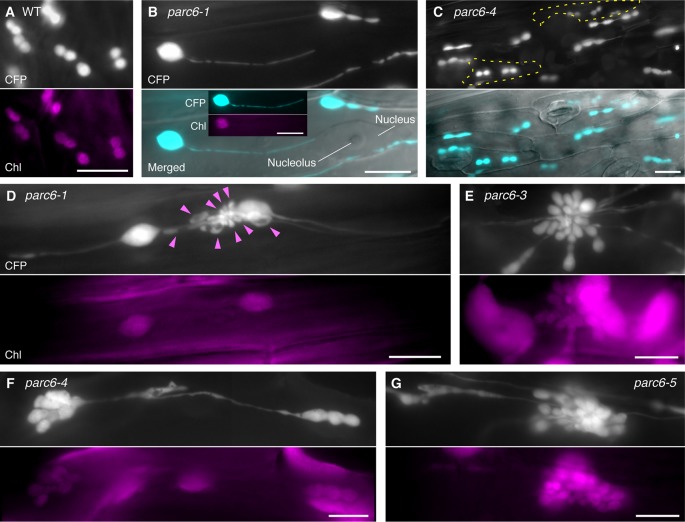
Morphology of plastids in leaf epidermal pavement cells of parc6 mutants. (A–G) Images of pavement cells in the 3rd and 4th leaf petioles of 2-week-old wild-type (WT) (A), parc6-1
(B, D), parc6-3
(E), parc6-4
(C, F), and parc6-5
(G) seedlings. Images of stroma-targeted CFP, chlorophyll autofluorescence, or differential interference contrast (DIC), and merged images of CFP and DIC (B, C) are shown. Inset in (B) indicates chlorophyll autofluorescence in a stromule-producing pavement cell chloroplast. Yellow regions in (C) indicate pavement cells with symmetric chloroplast division. Arrowheads in (D) indicate chlorophyll-less plastids or bulges. Scale bar = 10 µm.